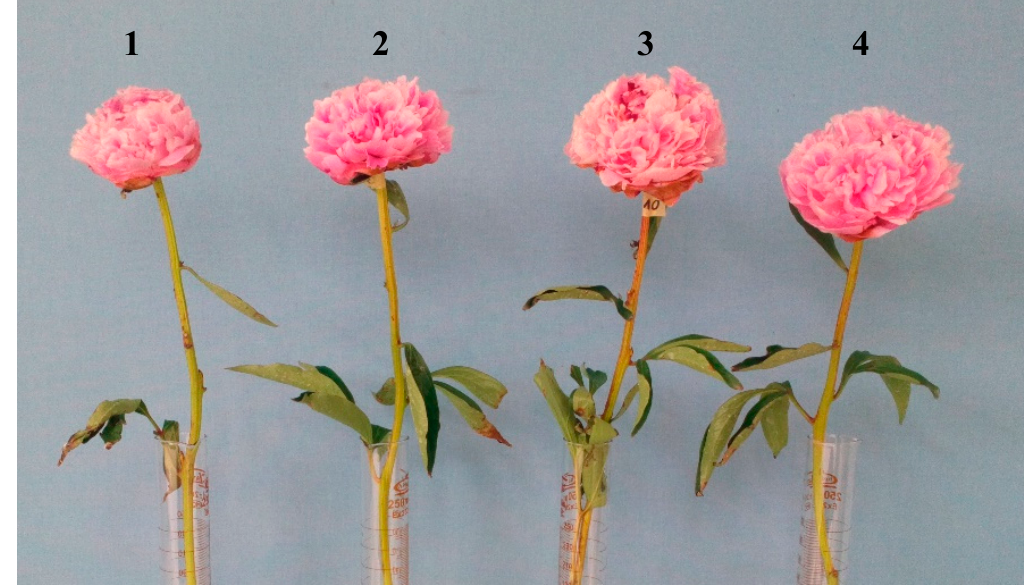
Figure 1. The effect of 12 weeks storage and application of holding solutions after storage, on the appearance of cut ‘Sarah Bernhardt’ flowers after 8 days of vase life. 1 = water; 2 = 8-HQC + 2%S; 3 = NS + 2%S; 4 = NS + 4%S.